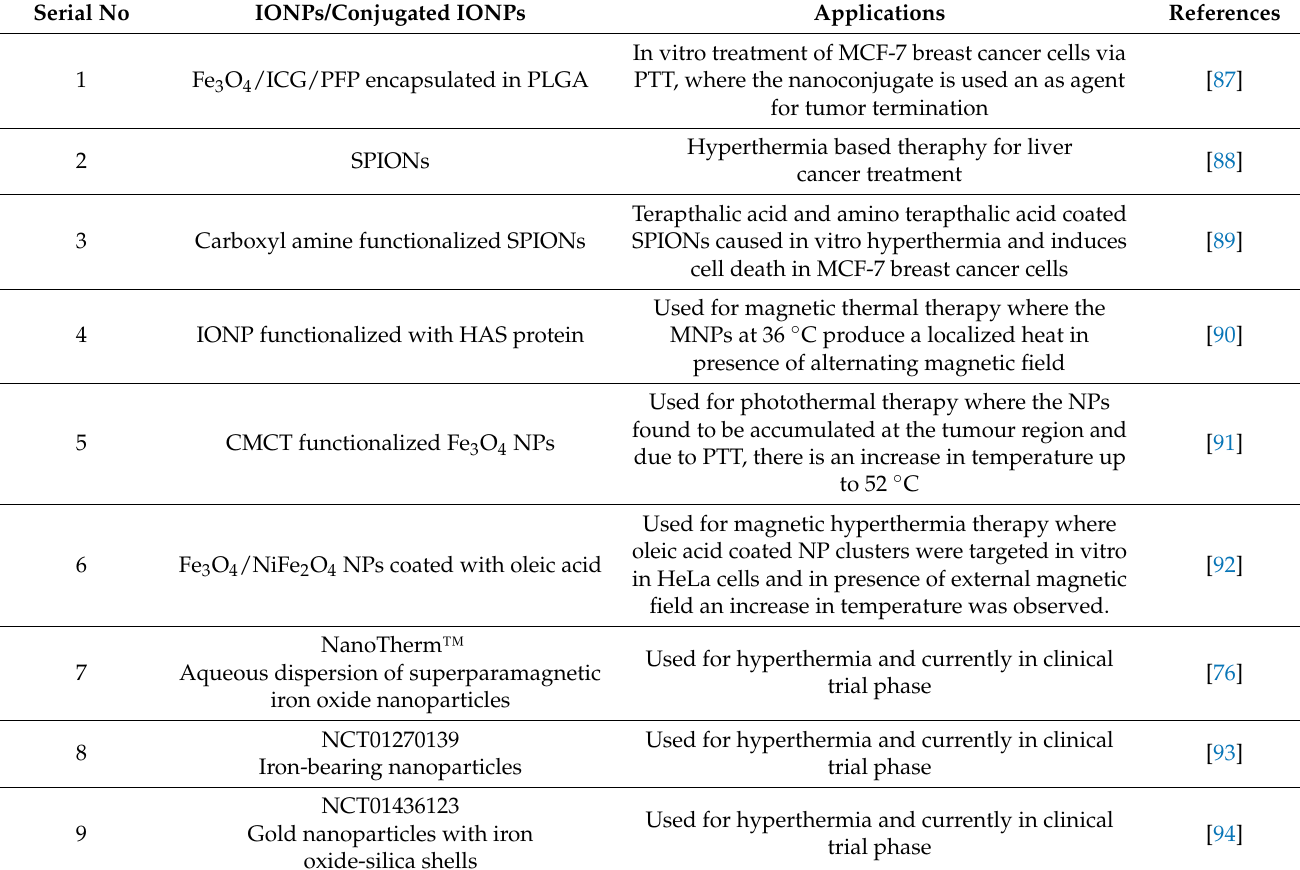
Table 4. Summary of functionalized IONPs with high potential for magnetic thermal therapy/photo thermal therapy in diminishing tumour affected